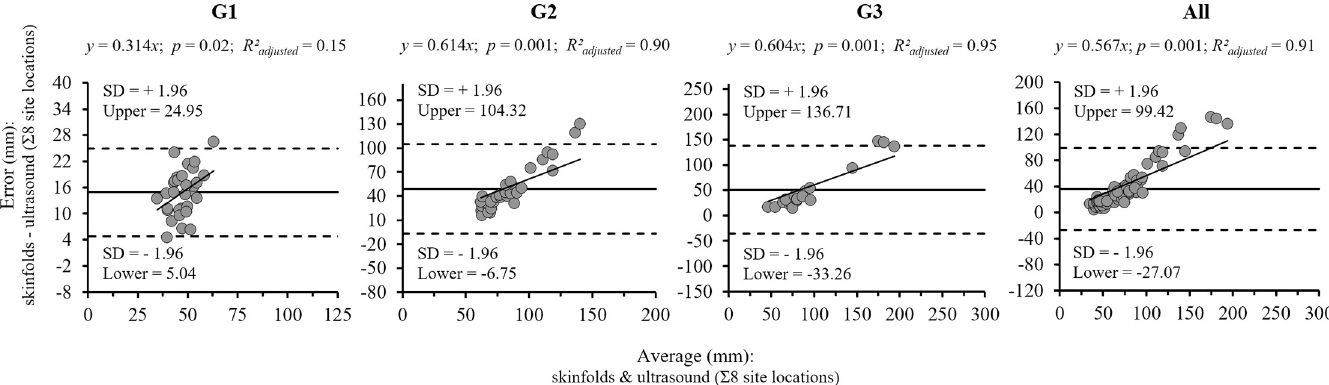
PLOS ONE | https://doi.org/10.1371/journal.pone.0205226 November29,